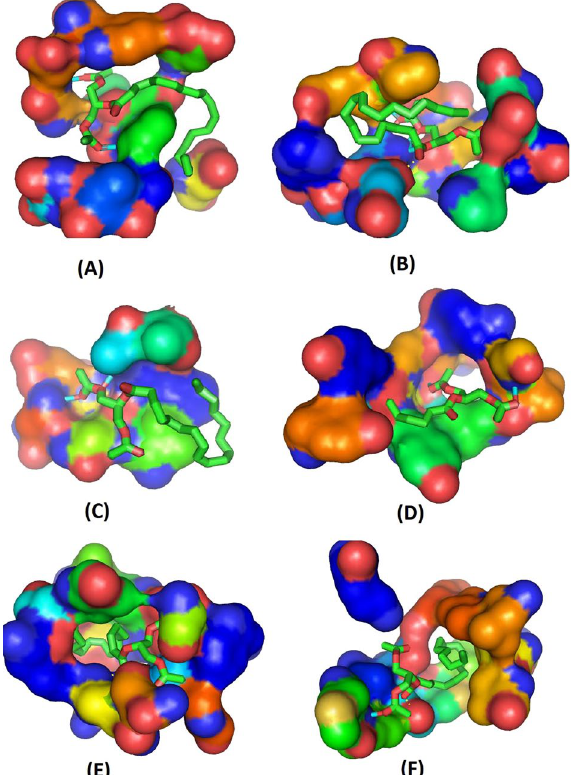
Fig. 9 3D surface interaction and conformation between Oleoyl chloride (Cp6) against six selected target proteins of Ruellia herbs. A Cp6 and CB2; B Cp6 and IL-1 β ; C Cp6 and IL-6; D Cp6 and TNF; E Cp6 and PTGS1; F Cp6 and DOPR. The blue colour indicates hydrogen bond interactions with side chain amino acid (mild polar) and pink represents the hydrophobic